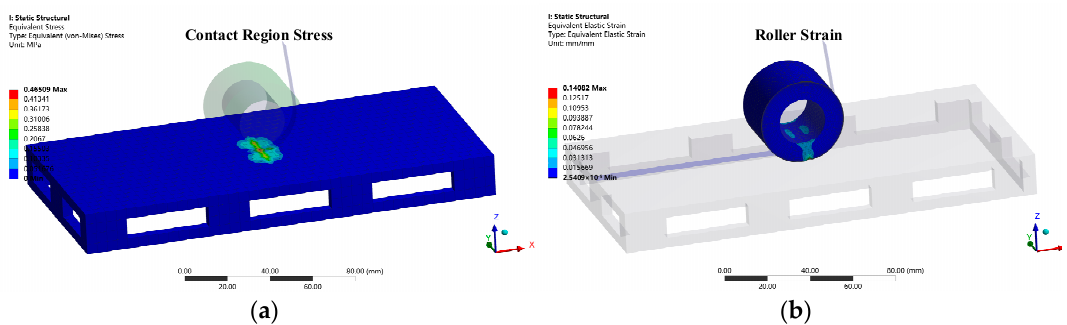
Figure 7. Nephogram of finite element simulation results: ( a ) Simulation results of contact stress; ( b ) Simulation results of roller strain.